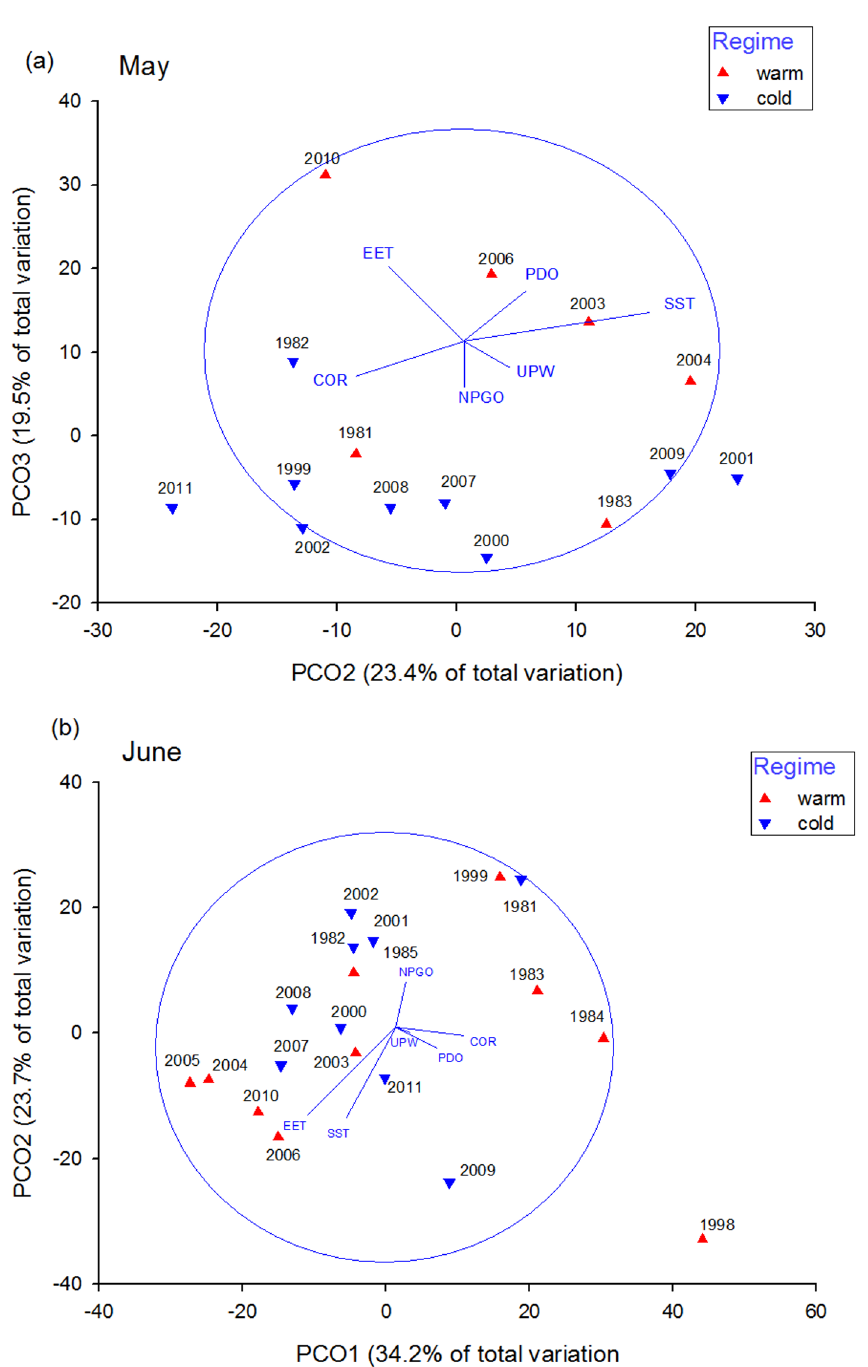
Fig 2. Principal Coordinate Analysis (PCO) of juvenile Chinook salmon diet composition in May (a) and June (b). Each data point on the PCO plot represents the average annual diet composition of juvenile Chinook salmon for May and June. The vectors show the direction and relative strength of the environmental variables examined and the circle represents equilibrium.